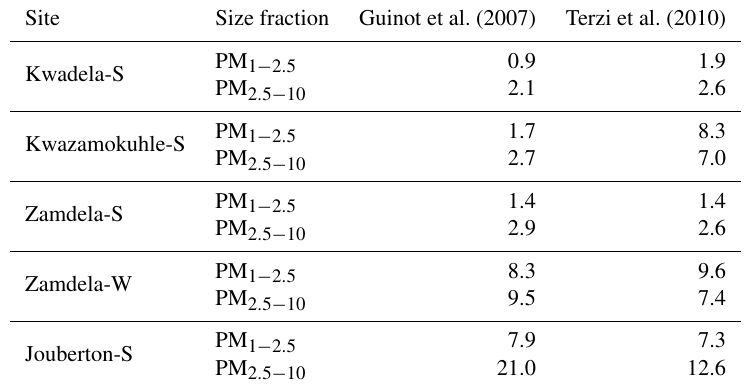
Table 6. Dust concentrations (µgm − 3 ) estimated according to the methods of Guinot et al. (2007) and Terzi et al. (2010).